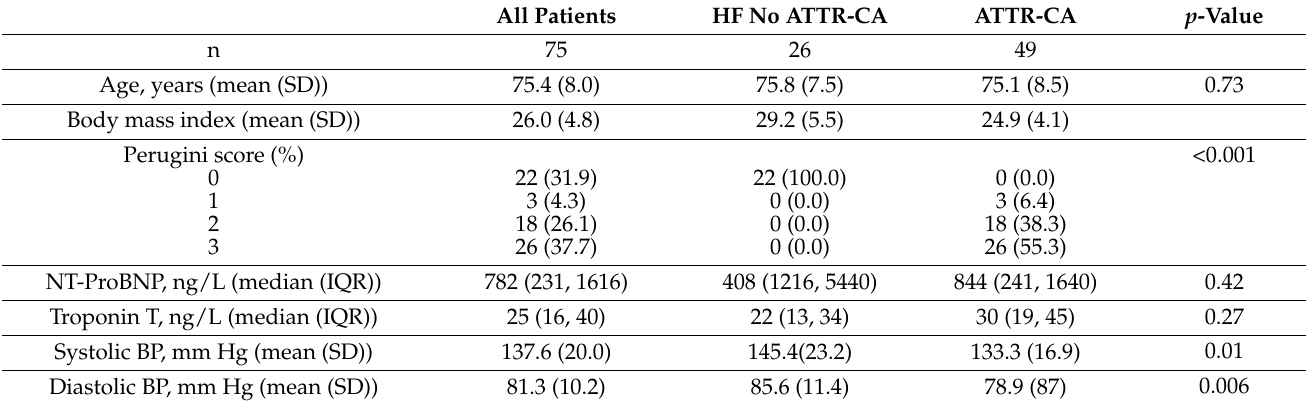
Figure 2. Flowchart of patient inclusion and exclusion. Abbreviations: ICD—International Classification of Diseases; ATTR-CA—transthyretin cardiac amyloidosis, ATTRv—amyloid transthyretin variant; AL—amyloid light-chain. Table 1. Baseline and echocardiographic characteristics.